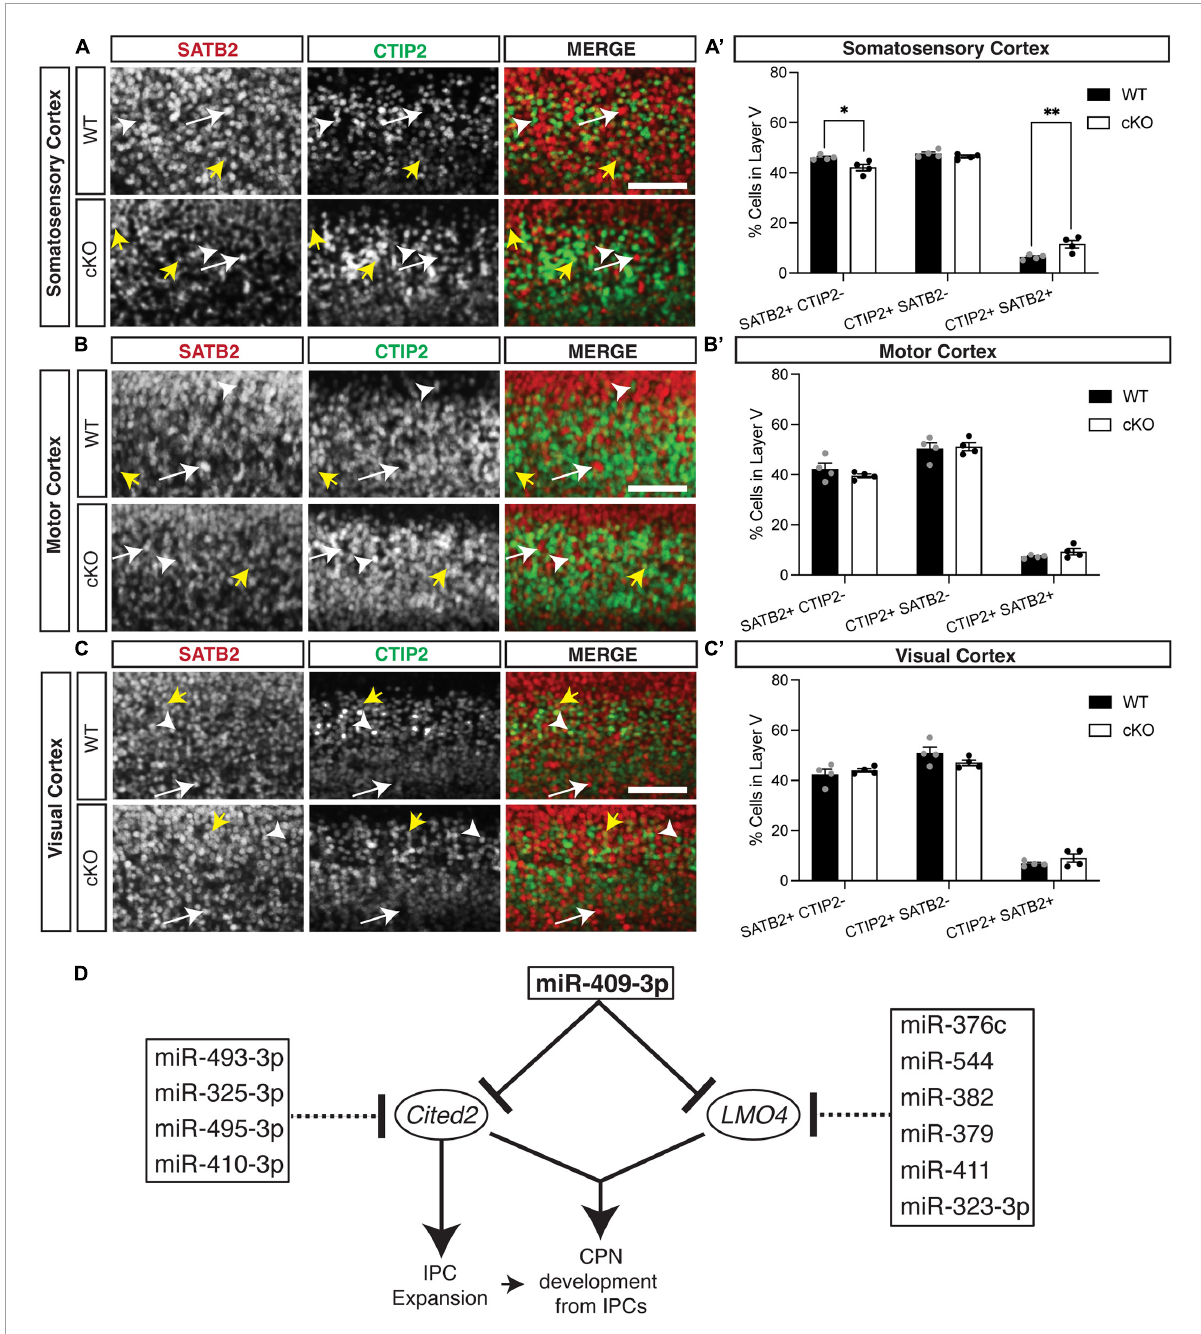
FIGURE4 Cited2 loss-of-function increases co-expressing SATB2 and CTIP2 cells at the expense of callosal projection neurons in layer V of the e18.5 developing somatosensory cortex. (A,A (cid:48) ) Conditional loss of Cited2 generates fewer SATB2 + CTIP2- (white arrow) neurons and more SATB2 + CTIP2 + co-expressing neurons (yellow arrows) in layer V of the somatosensory region without altering the population of CTIP2 + SATB2- neurons (white arrow head). These differences were not observed in the developing motor region (B,B (cid:48) ) or visual region (C,C (cid:48) ) . n = 4. ∗ p < 0.05; ∗∗ p < 0.01 (Two-way ANOVA with Šídák’s multiple comparisons test). Error bars denote SEM. Scale bars = 100 µ m. (D) Schematic of the cooperative and multi-target repression of the Cited2-Lmo4 pathway for callosal projection neuron development by the corticospinal-expressed miRNAs of the Mirg /12qF1 cluster. miR-409-3p represses the interacting, callosal-expressed genes Cited2 and Lmo4 during cortical projection neuron development. Four corticospinal-enriched Mirg /12qF1 cluster miRNAs, in addition to miR-409-3p, are predicted to cooperatively repress Cited2. Six other corticospinal-enriched Mirg /12qF1 cluster miRNAs, in addition to miR-409-3p, are predicted to cooperatively repress